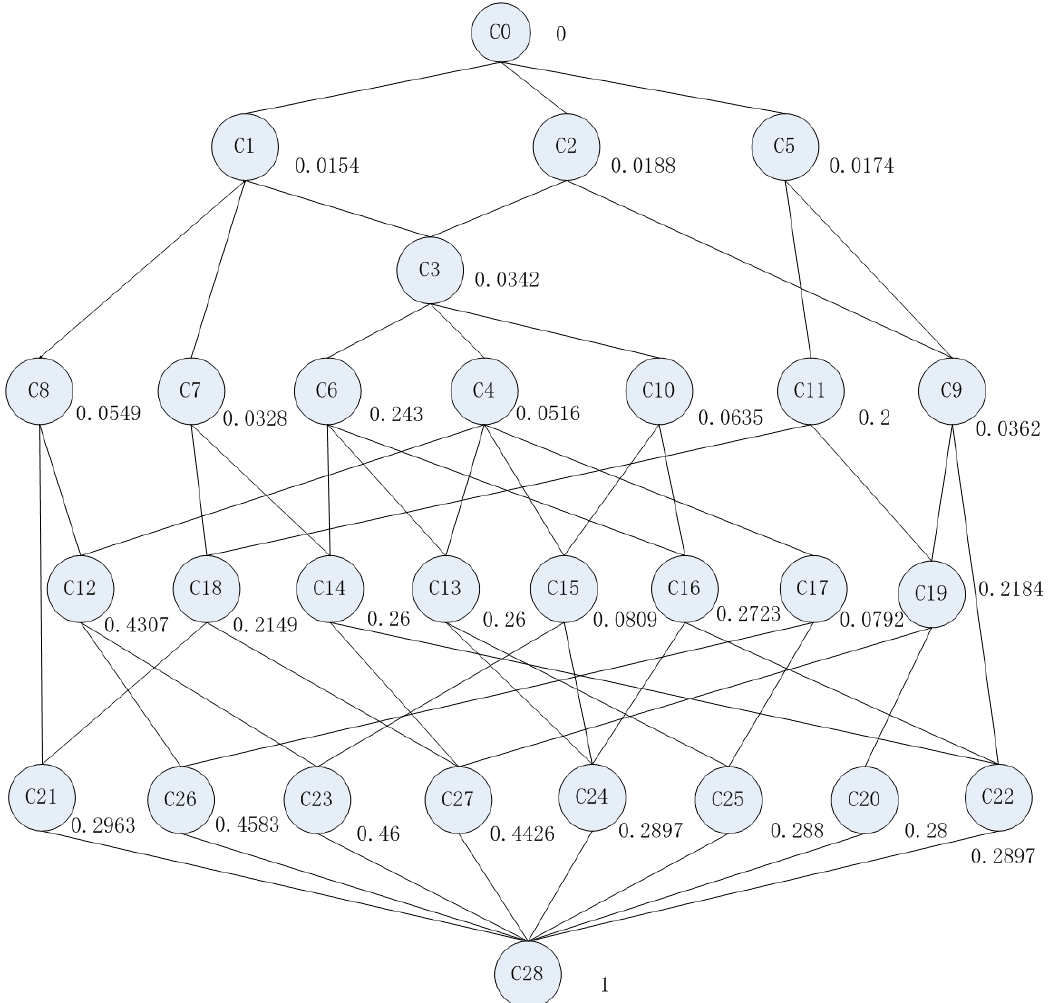
Figure 3. The weighted concept lattice (established by linking weighted formal concepts).